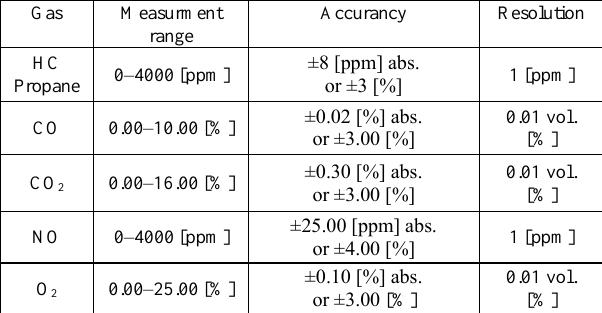
Fig. 2. Mobile exhaust gas analyzer Axion RS [8] Table 1. Technical parameters from the analyzer device